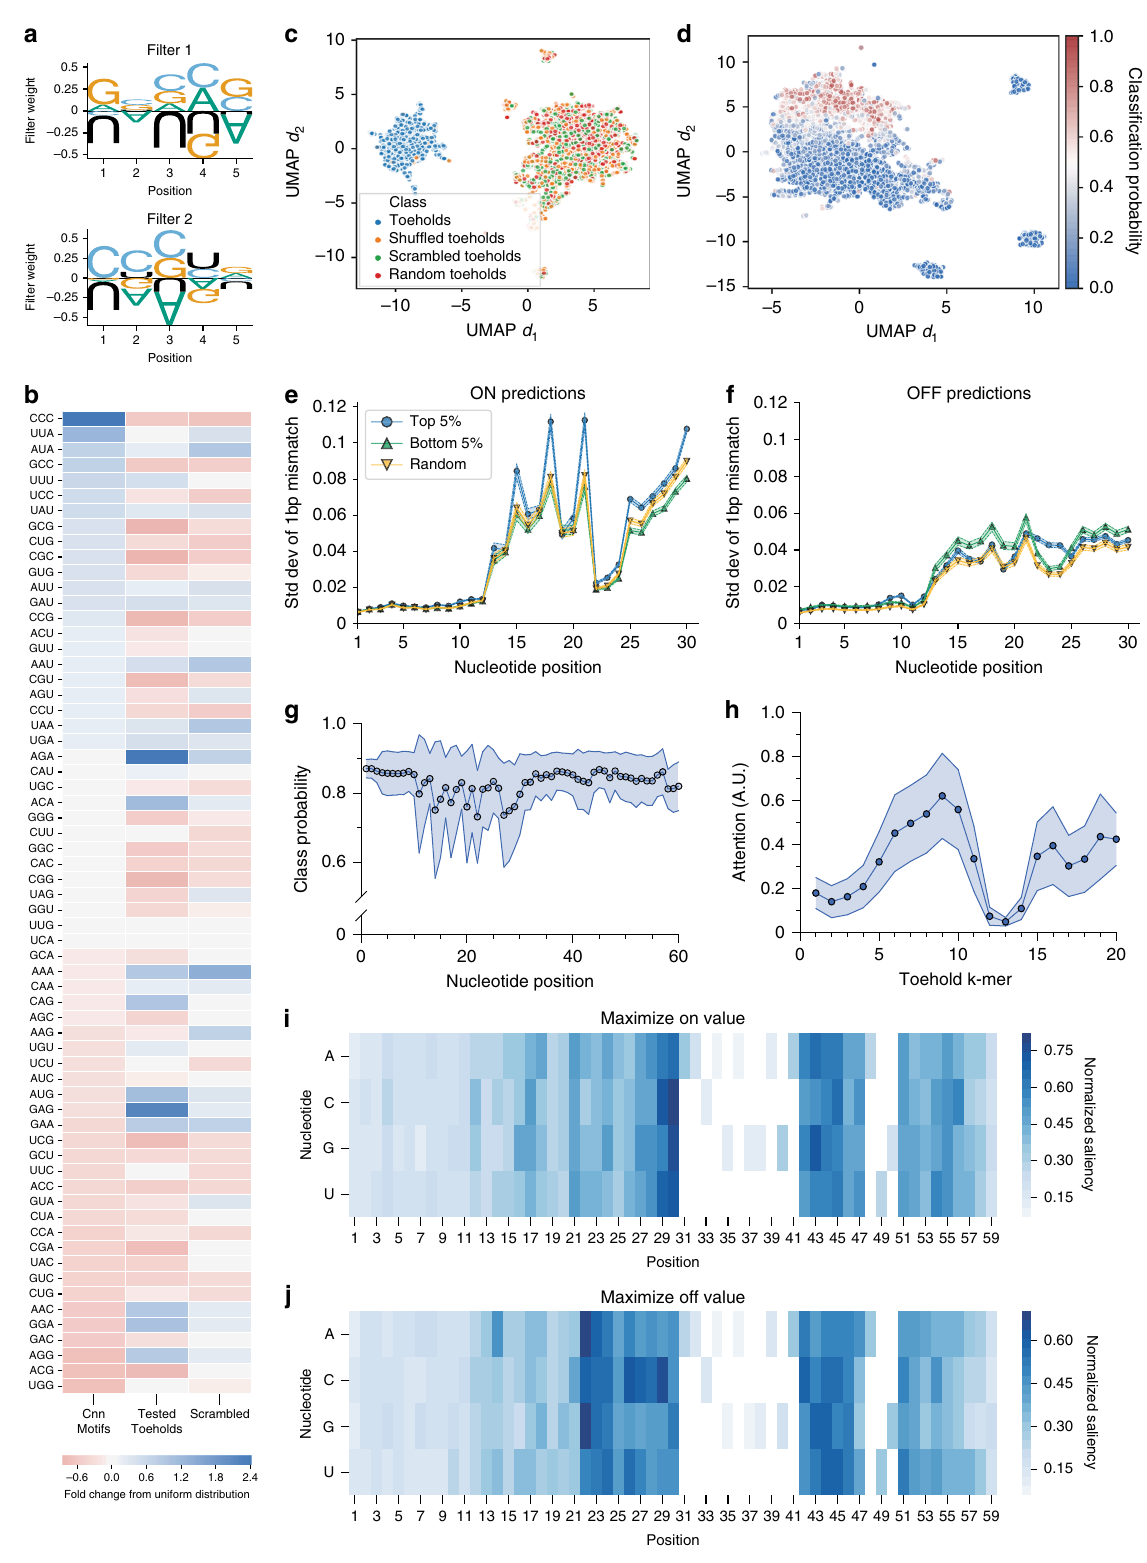
compared to both scrambled and shuf fl ed — which are scrambled after tokenization — input sequences, as well as random sequences. We observed no overlap between real toehold sequences and controls on the two-dimensional manifold, suggesting that the LM captured the importance of motif order in a toehold sequence.